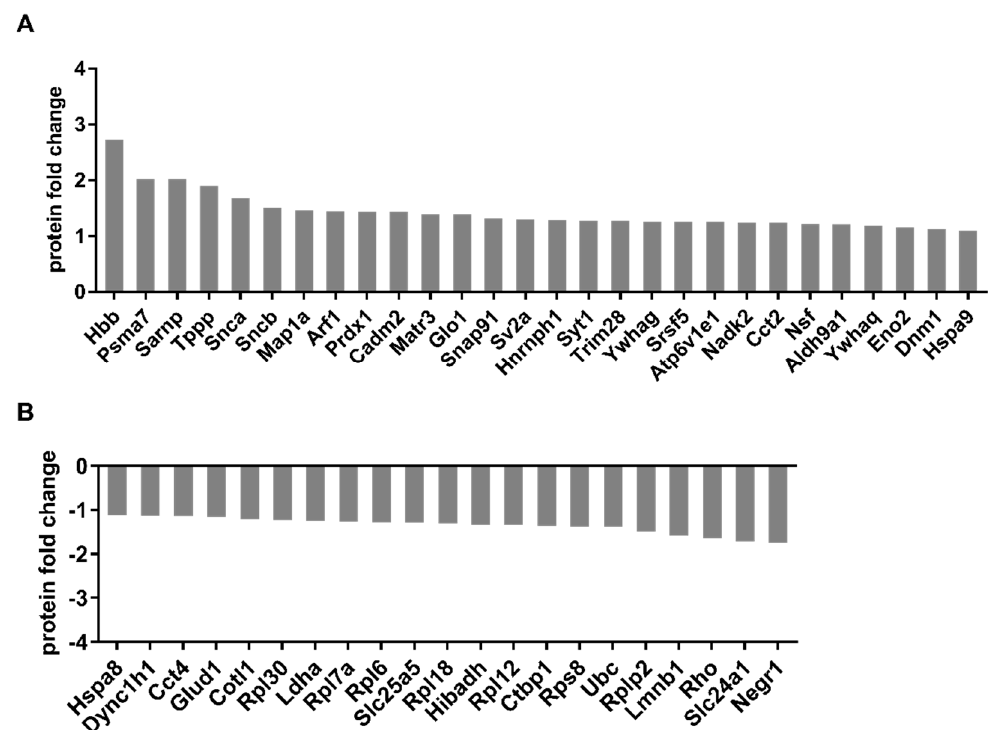
Figure 7. Illustration of the up- and down-regulation of significantly altered protein expression identified by mass spectrometric analysis. After sacrifice of the animals at the end of the study, the proteins were isolated from retinal tissue and tryptically digested. The resulting peptides were purified and analyzed by MS. Identification, quantification and normalization of the peptides was performed using MaxQuant. For statistical analysis, a Student’s t -test was used with a significance level p < 0.05. The graph shows the up—( A ) and down-regulated ( B ) proteins in the antibody-treated group compared to the control group. Numbers of animals used: n = 7 (IgG), n = 8 DNM1L. Clusters of significantly changed proteins can be identified, which might be related to neuronal activity or mitochondrial dynamics. To identify the association of these proteins with DNM1L, a STRING protein–protein interaction network analysis was performed (Figure 8).